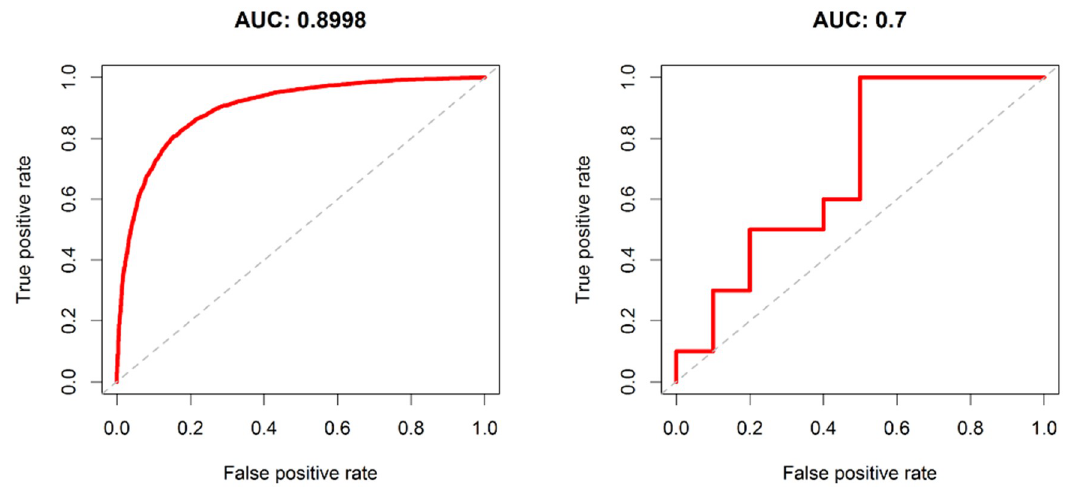
Fig 5. ROC-curves of the validated